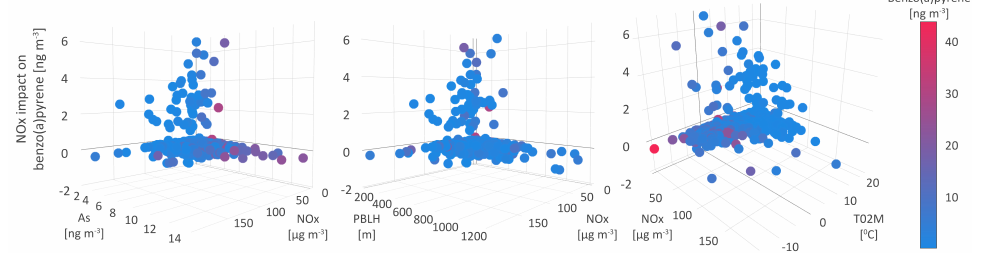
Figure 10. Nitrogen oxides impact on